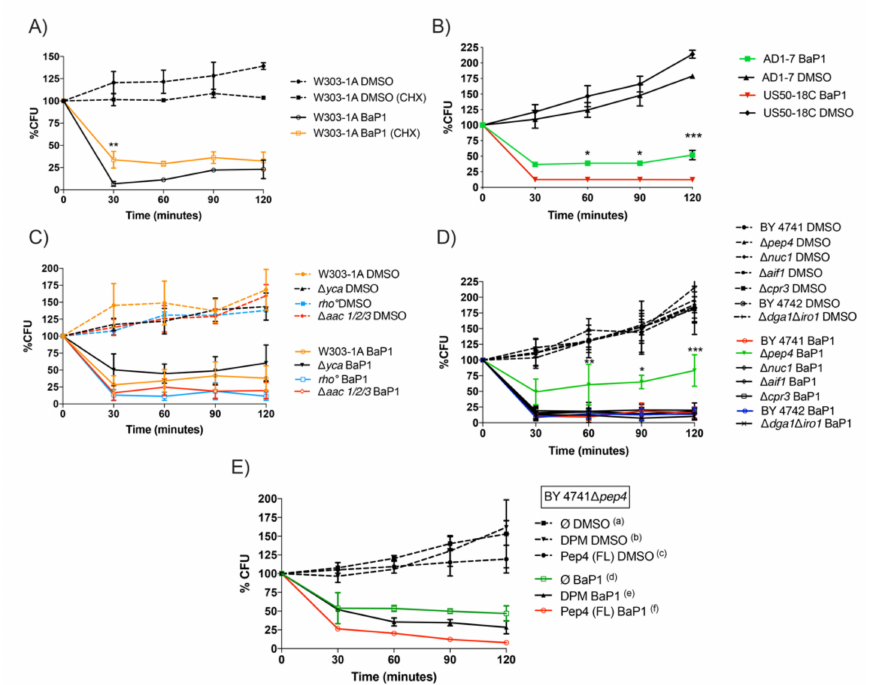
Figure 2. Effect of BaP1 on yeast cellular viability. ( A ) Effect of cycloheximide (CHX) (100 µ g/mL) on viability of S. cerevisiae W303-1A exponential cells, exposed to BaP1 (300 µ M) and DMSO (0.35%) (negative control). Cycloheximide was added 30 min before the beginning of BaP1 treatment. ( B ) Effect of BaP1 (300 µ M) and DMSO (0.35%) on cell viability of S. cerevisiae AD1-7 and US50-18C strains. ( C ) Effect of BaP1 (300 µ M) and DMSO (0.35%) on cell viability of S. cerevisiae W303-1A, ∆ yca1, ∆ aac 1/2/3, rho 0. ( D ) Effect of BaP1 (300 µ M) and DMSO (0.35%) on cell viability of S. cerevisiae BY4741, BY4742, ∆ pep4, ∆ nuc1, ∆ aif1, ∆ cpr3, and ∆ dga1 ∆ iro1 strains. ( E ) Effect of BaP1 (300 µ M) and DMSO (0.35%) on cell viability of S. cerevisiae BY 4741 ∆ pep4 pESC(Ø), BY 4741 ∆ pep4 pESC-DPM-Pep4p and BY 4741 ∆ pep4 pESC-Pep4p(FL) strains. 30 min: (d vs. e) ns, (d vs. f) **, (e vs. f) **; 60 min: (d vs. e) *, (d vs. f) ***, (e vs. f) ns; 90 min: (d vs. e) ns, (d vs. f) ***, (e vs. f) *; 120 min: (d vs. e) *, (d vs. f) ***, (e vs. f) *. Cell viability was assessed by CFU counting at the different time points (0, 30, 60, 90, 120 min). The time 0 corresponds to 100% is the CFU counting before BaP1 and DMSO treatment. Values are means with SD ( n ≥ 2). Statistical analysis was performed by two-way ANOVA. * p < 0.05, ** p < 0.01, *** p <